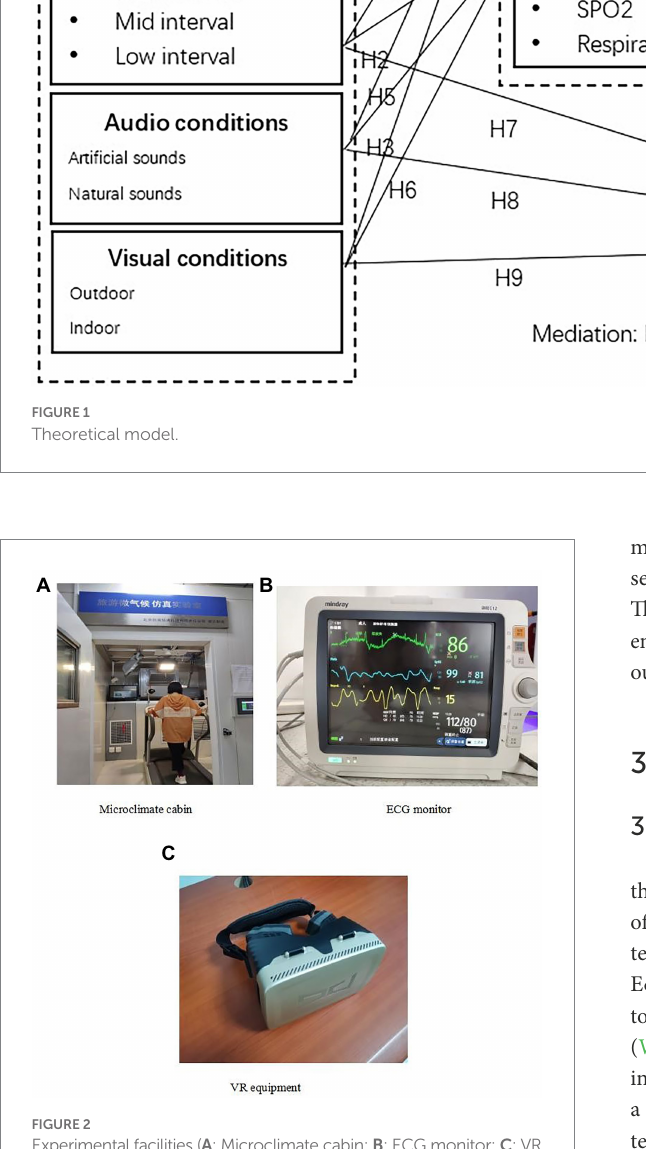
Figure 2B); a VR helmet (to simulate an immersive tourism situation; Figure 2C), etc. The size of the tourism simulation